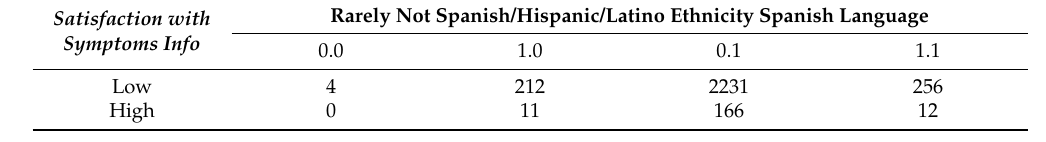
Table 12. Contingency Table with Combined Rows.